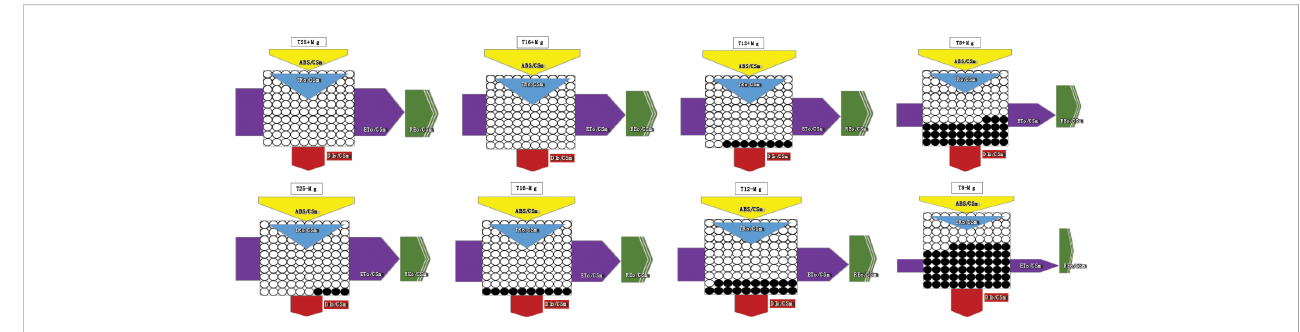
FIGURE 9 Leaf membrane model of tobacco plant with chlorophyll fl uorescence